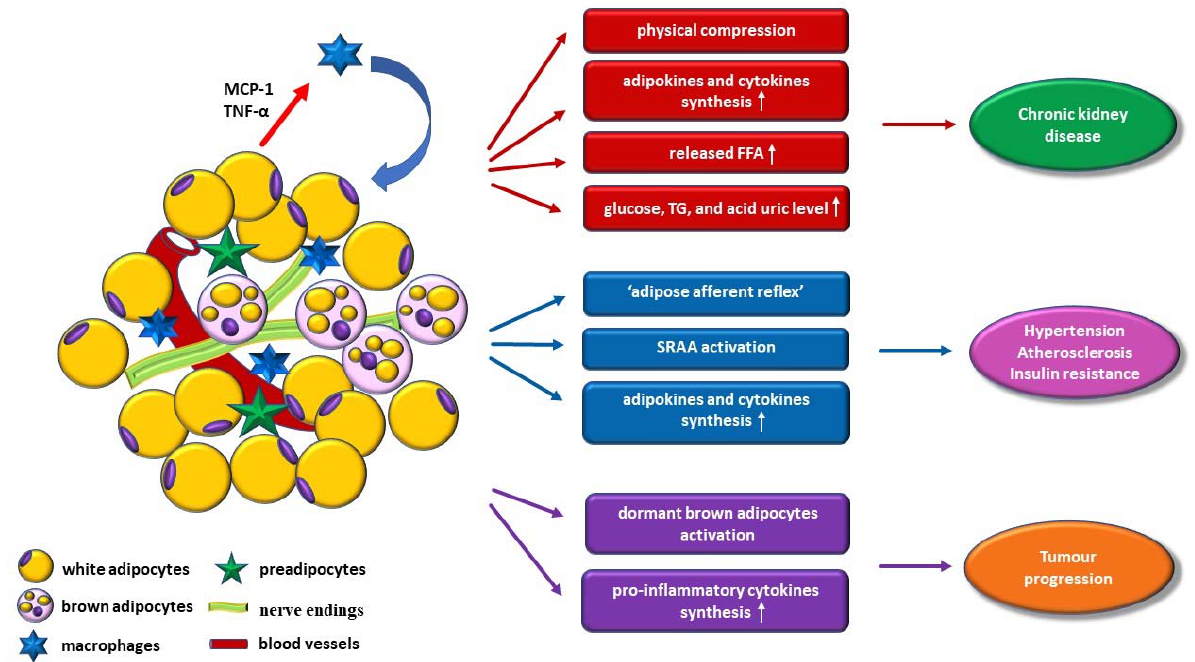
Figure 1. Schematic diagram of perirenal adipose tissue involvement in pathology. FFAs—free fatty acids; MCP-1—monocyte chemoattractant protein-1; SRAA—renin-angiotensin-aldosterone system; TGs—triglycerides; TNF- α —tumor necrosis factor- α ; ↑ —increased level.